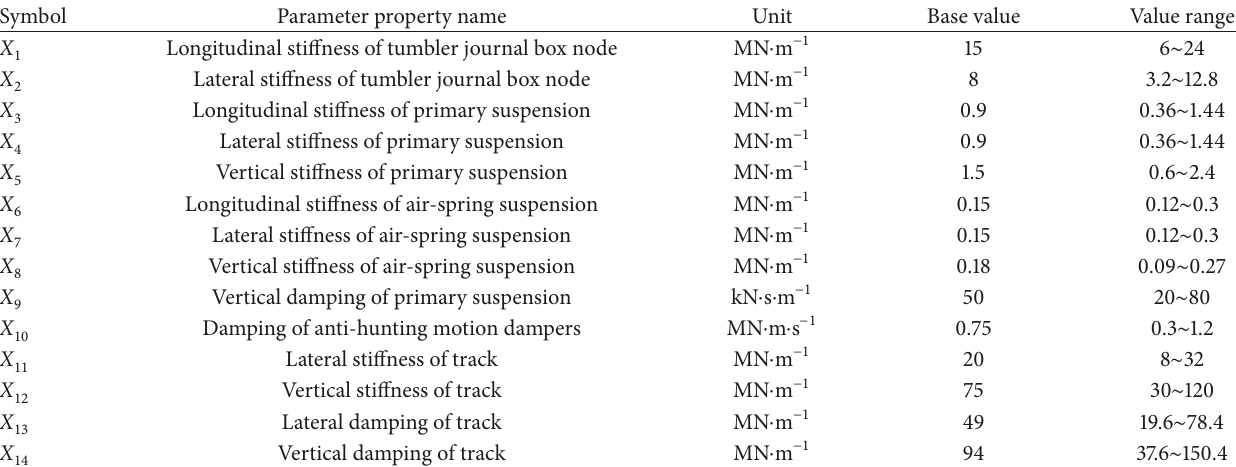
Table 2: Design variables of vehicle and track parameters.